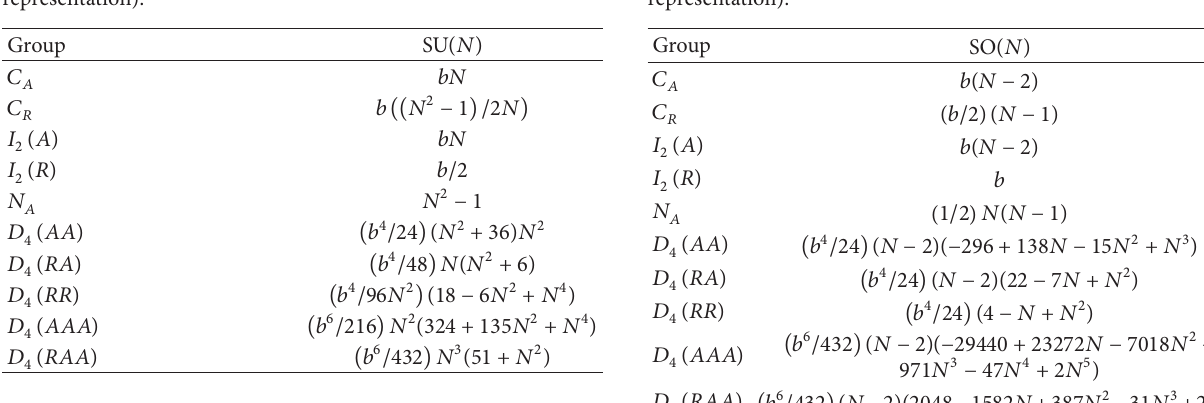
Table 3: SO (𝑁) Group invariants (here 𝑅 is the fundamental representation).